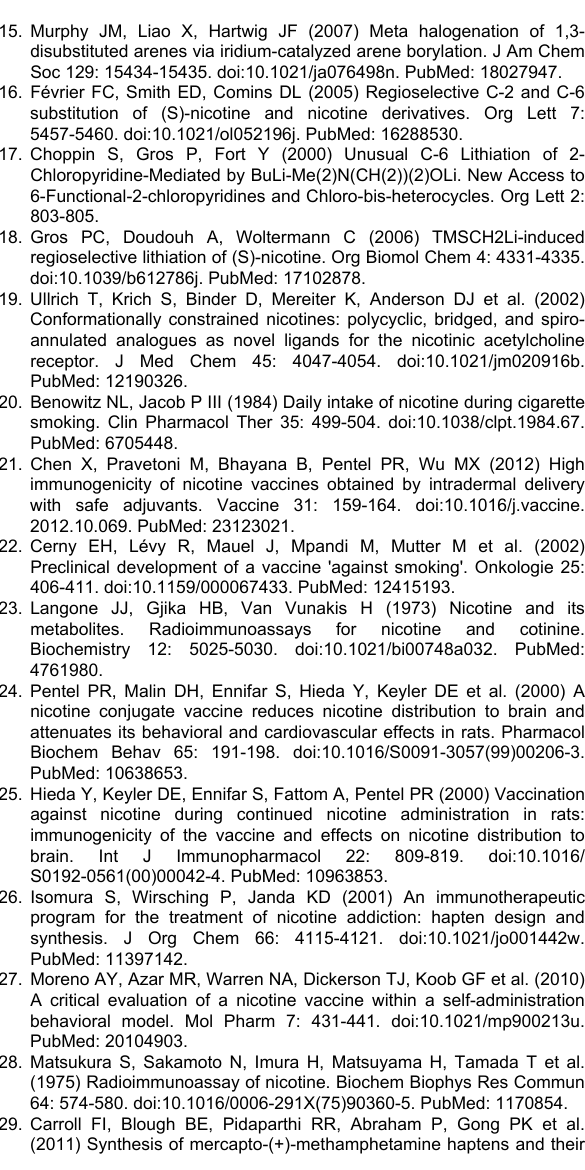
Figure S37. Preparation of 3-(1'-methyl-5,6- dihydrospiro[cyclopenta[c]pyridine-7,2'-pyrrolidine]-4- yl)propanoic acid sodium salt (Hapten 9).